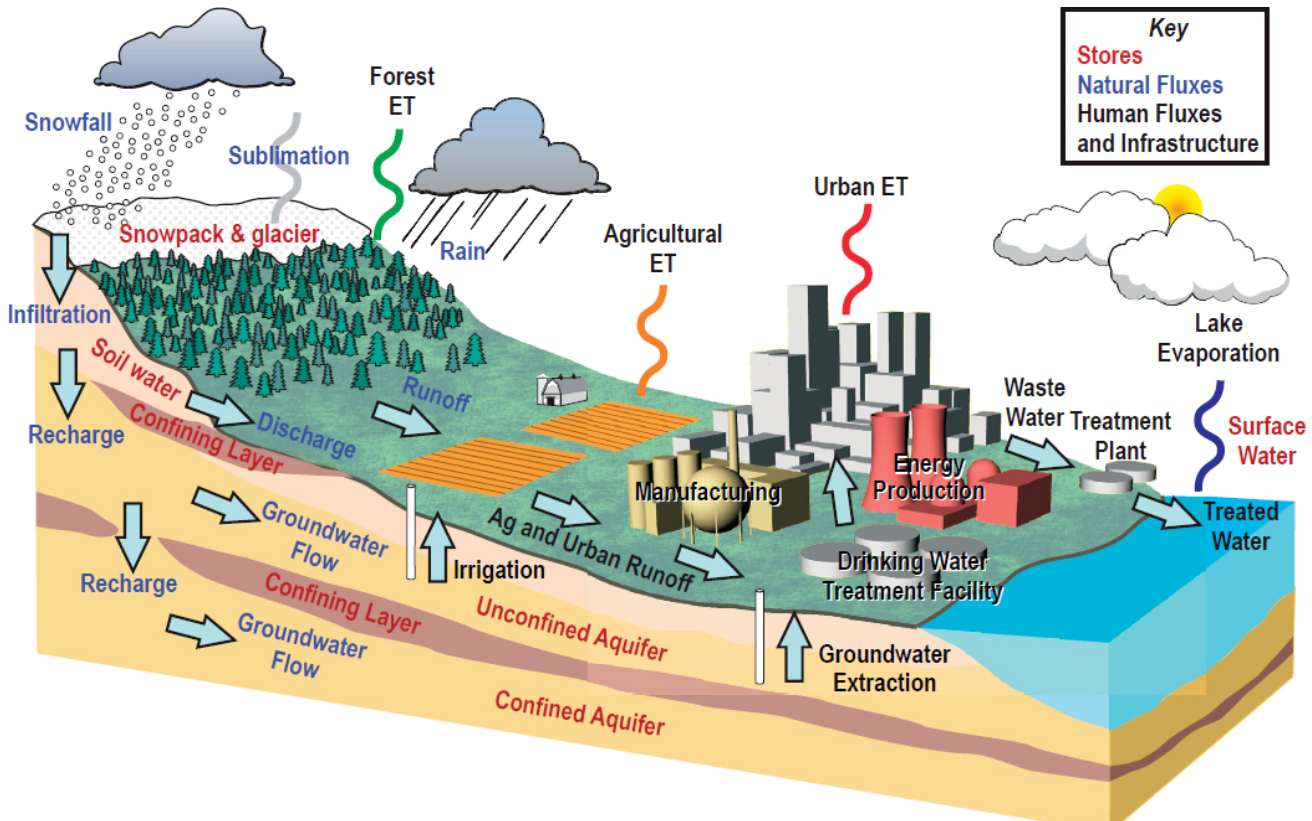
Figure 4. Global water cycle, source: Courtesy of Jerald Schnoor.